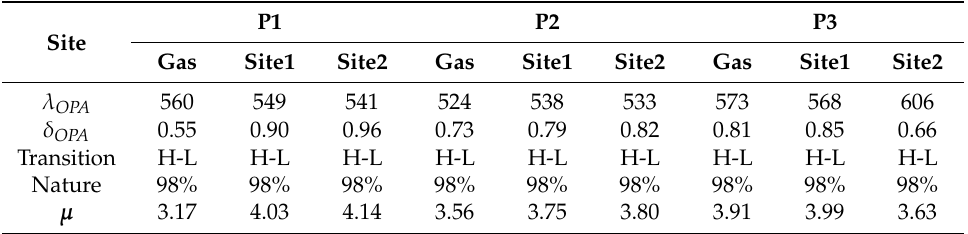
Table 2. OPA wavelength  OPA (nm), oscillator strength  OPA (a.u.), transition nature, and the dipole moment  (Debye) for P1, P2, and P3 in different microenvironments in long wavelength region. H(L) denotes HOMO(LUMO).